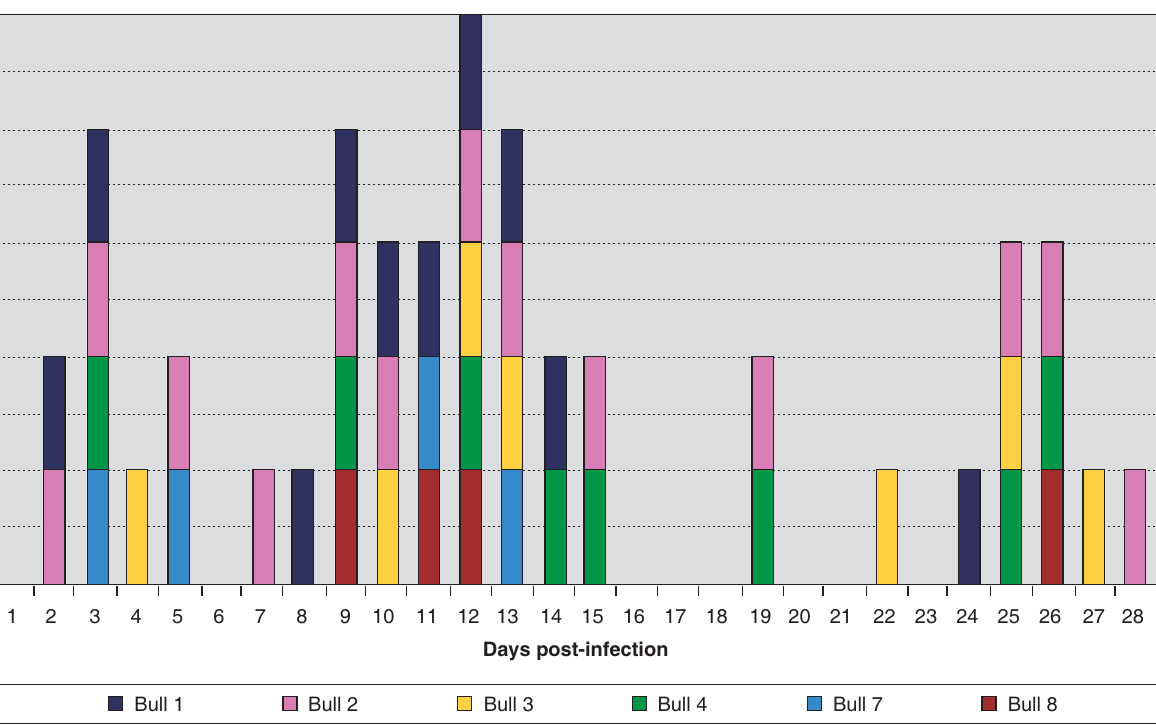
FIG. 2 Virus isolations on bovine dermis cell cultures from blood samples collected in heparin